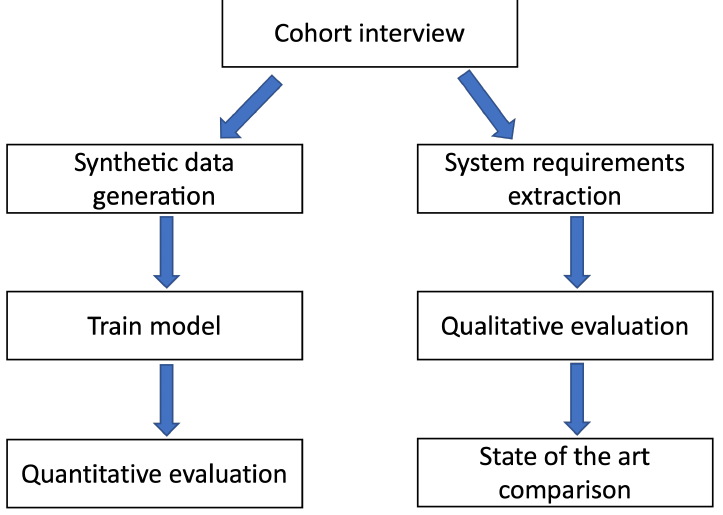
Figure 1. Research